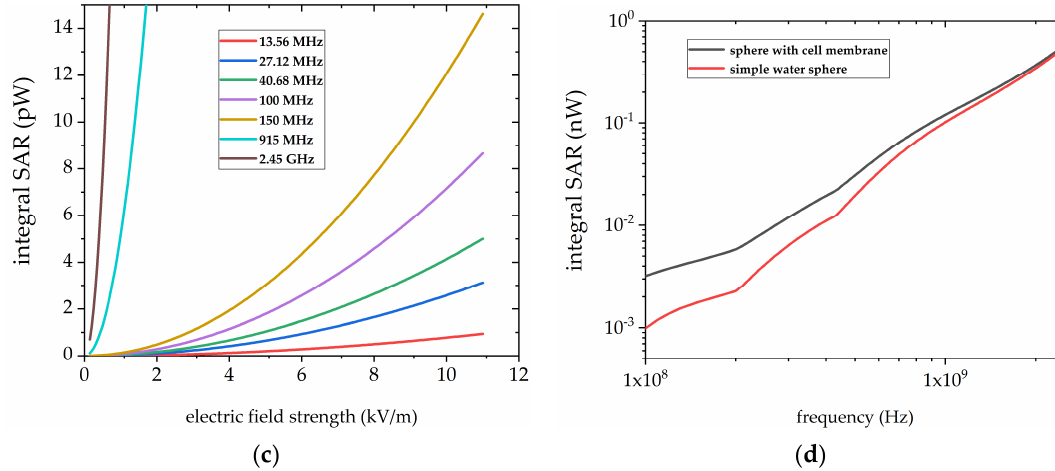
Figure 12. Specific absorption rate (SAR) of a ( a ) small spherical cell with an outer radius of R = 4 µm and a phospholipid bilayer with outer interface region ( S i = 2.2 nm), membrane core ( S c = 1.6 nm) and inner interface region ( S i = 2.2 nm) at hyperthermia relevant frequency of 2.45 GHz and an electric field strength of 1000 V/m; ( b ) Integral SAR at frequencies of 915 MHz (solid line) and 2.45 GHz (dashed lines) at three different cell radii (4, 8 and 14 µm) and variable electric field strength; ( c ) Integral SAR for a 4 µm cell depending on the electric field strength and ISM relevant frequencies; ( d ) Comparison of the integral specific absorption rate for a water sphere and a model cell with radius 4 µm in an electric field with 4 kV/m field strength and variable frequency.